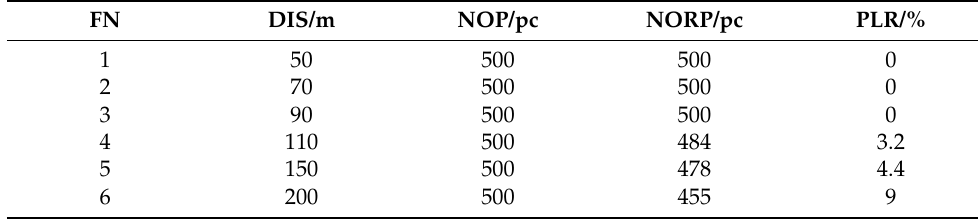
Table 3. Packet loss rate of the wireless transmission